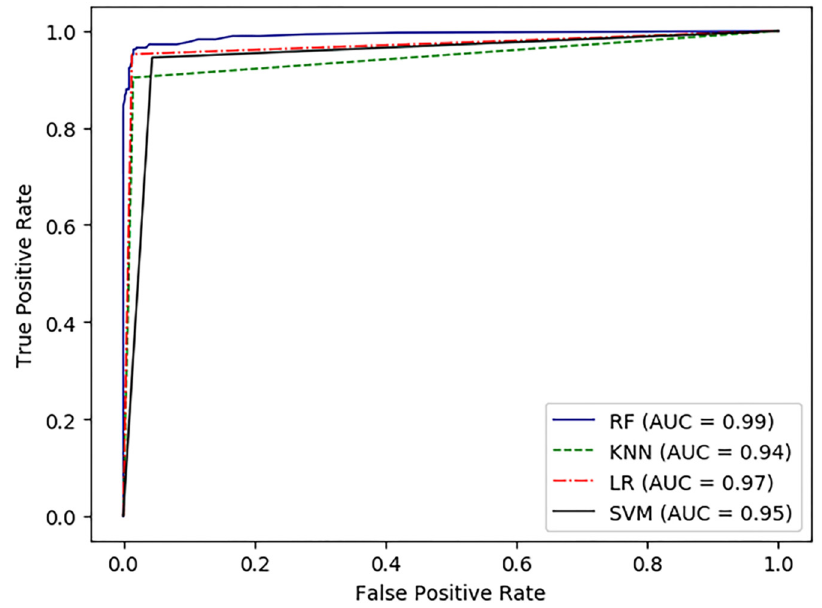
Figure 6. Receiver operating characteristic (ROC) curve analysis for RF, KNN, LR, and SVM classifier. Table 4. Per-segment classification results of different classifiers on the Apnea-ECG database.